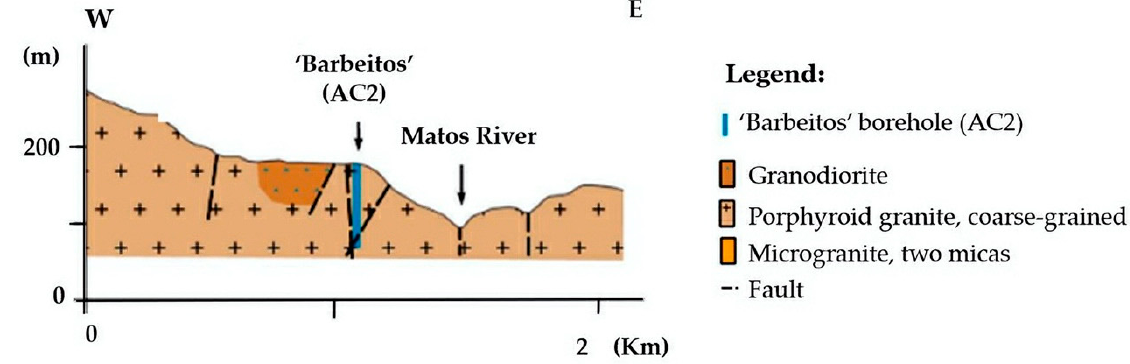
Figure 5. Geological profile of the area surrounding the ‘Barbeitos’ borehole (adapted from [68]).